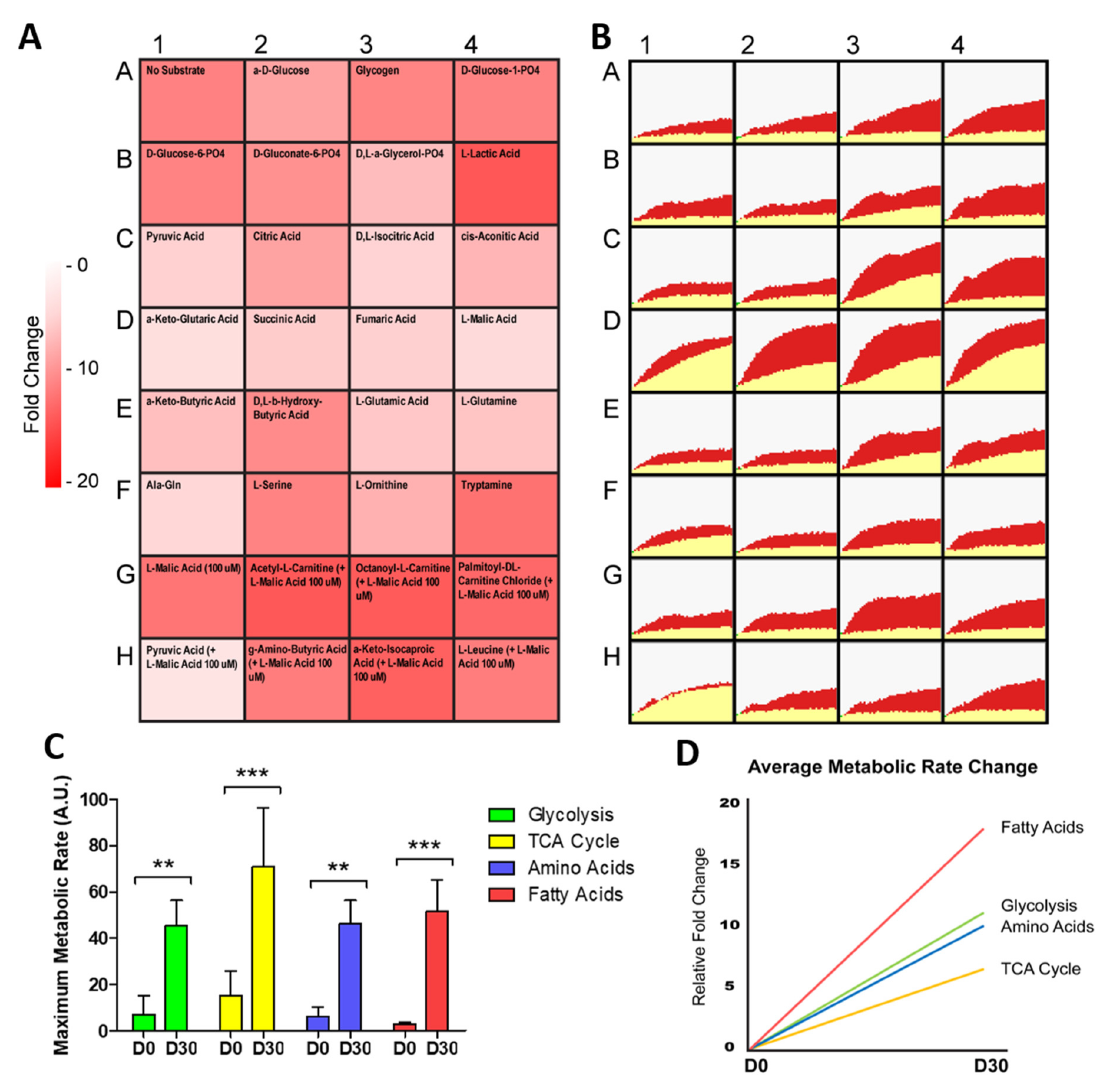
Figure 2. Change in metabolic rate during the differentiation of hiPSC-CMs. In ( A ), relative fold change in the rate of substrate metabolism for day 30 hiPSC-CMs normalised to undifferentiated day 0 hiPSCs is shown as a heat map. In ( B ), corresponding representative rate traces are shown for both day 30 hiPSC-CMs (shown in red) and day 0 hiPSCs (shown in yellow), highlighting the increase in rate. In ( C ), the maximum metabolic rate for substrates categorised in each of the glycolysis, TCA cycle, amino acid, and fatty acid substrate groups was averaged and plotted for day 30 hiPSC-CMs and day 0 hiPSCs. n = 3. In ( D ), the relative fold change in the grouped substrate average is plotted for day 30 hiPSC-CMs. Significance was determined by two-way ANOVA, ** p < 0.01, *** p <